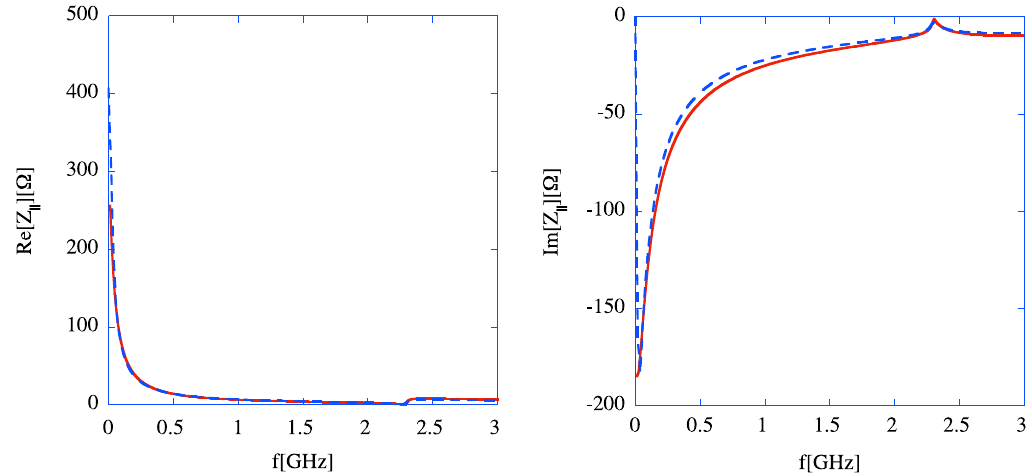
FIG. 2. (Color) Comparison of the real (left) and imaginary (right) parts of the longitudinal impedance, calculated by the present theory (red curves) and ABCI (blue curves), respectively. The parameters are as follows: (cid:6) (cid:4) 1000 , a (cid:4) 5 cm , w (cid:4) 4 mm , z (cid:4) 0 m , and (cid:3) (cid:4) a= 10